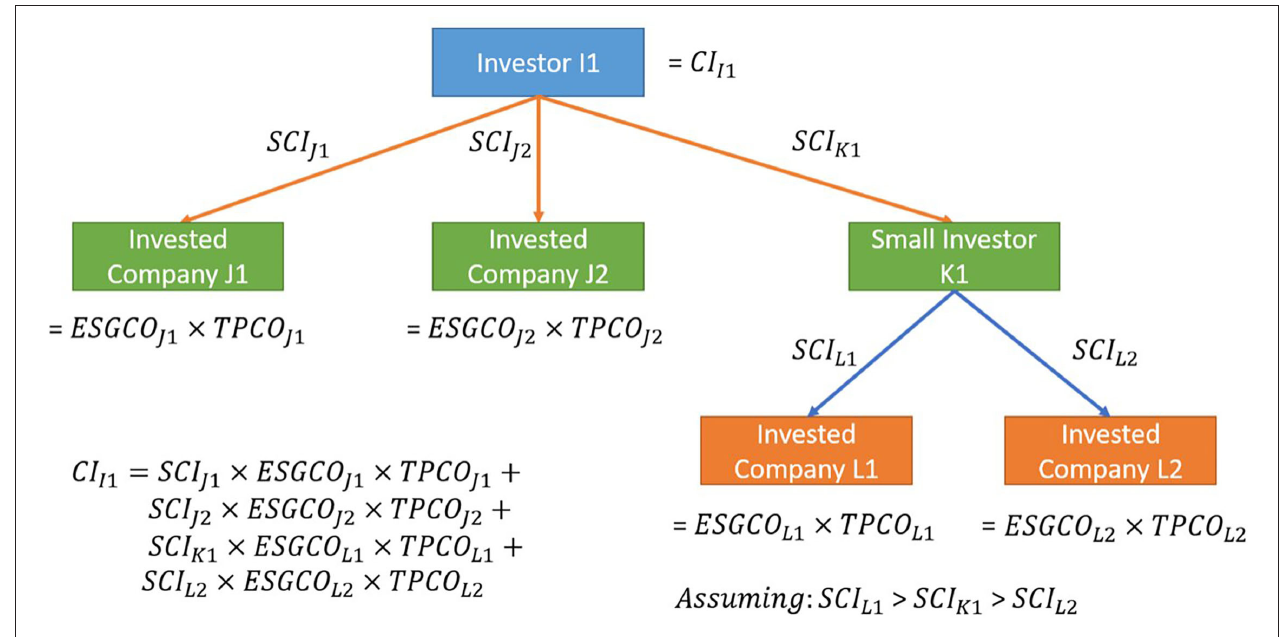
FIGURE 1 | Example to illustrate the calculation process.